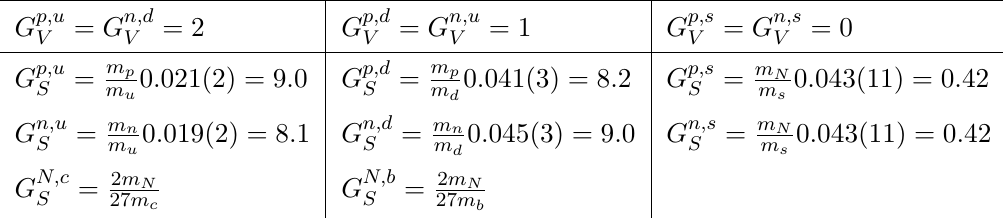
Table 1 . This table is taken from [28]. It gives matching coefficients between nucleon and light- quark-flavour-diagonal operators. The parenthese gives the uncertainty in the last figure(s). The G N,q